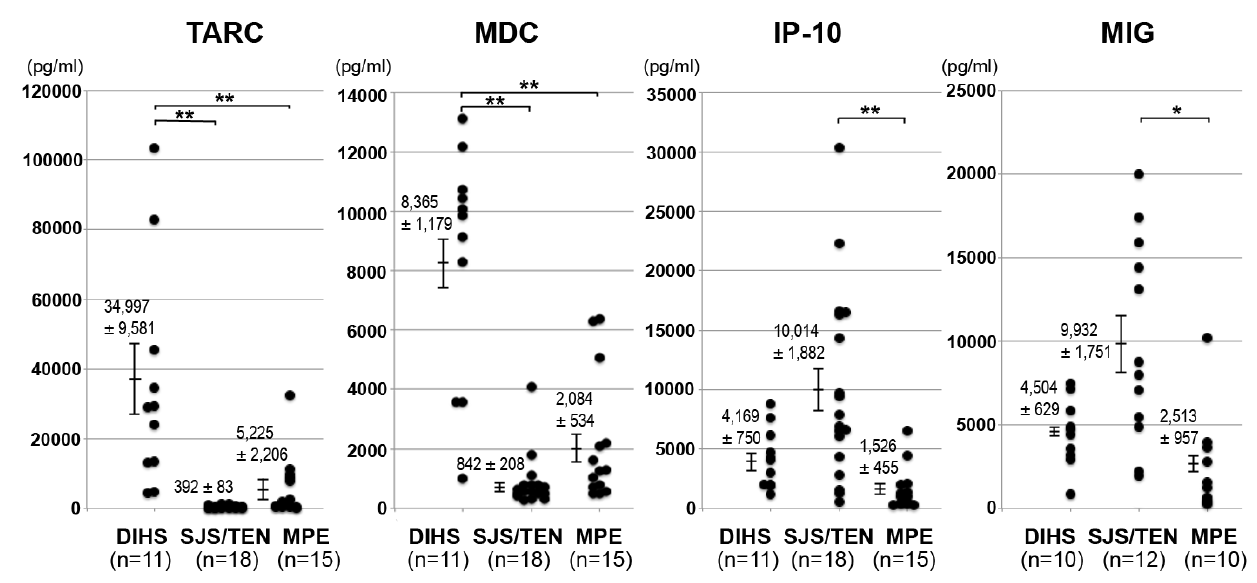
Figure 2. Distinct chemokine expression profiles of SCARs in the acute stage. The levels of Th2-associated chemokines (TARC and MDC) were markedly elevated in DIHS/DRESS, while Th1-associated chemokines (IP-10 and MIG) predominated in SJS/TEN. The study included 11 patients with DIHS/DRESS (7 males and 4 females; median age: 49 years, range: 16–68),18 patients with SJS/TEN (8 males and 10 females; median age: 70.5 years, range: 17–91), and 15 patients with MPE (7 males and 8 females: median age: 63 years, range: 31–78). * p < 0.05, ** p < 0.01. (adapted from